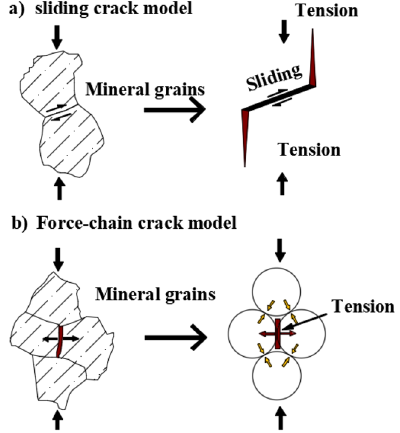
Figure 1. Two crack propagation modes in rocks 17